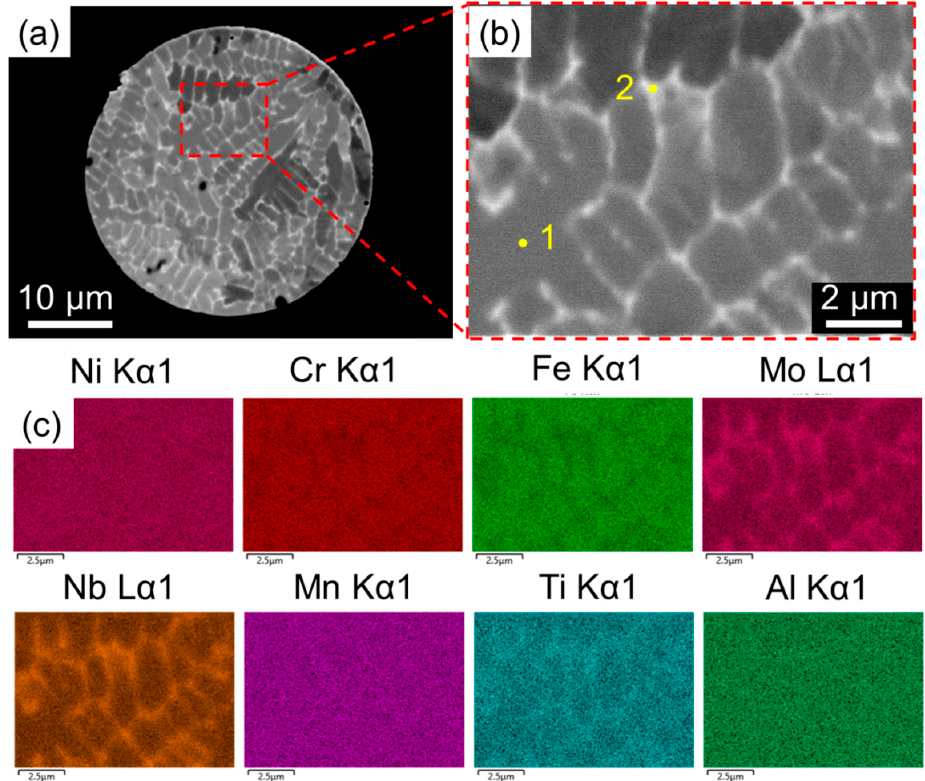
Figure 4. ( a ) BSE-SEM cross-sectional micrograph of an IN718 particle, ( b ) an enlarged view of the ‘red square’ in ( a ), and ( c ) the corresponding EDS mappings of different chemical elements. Table 1. Chemical compositions of primary dendrite and interdendritic phase in IN718 powder.